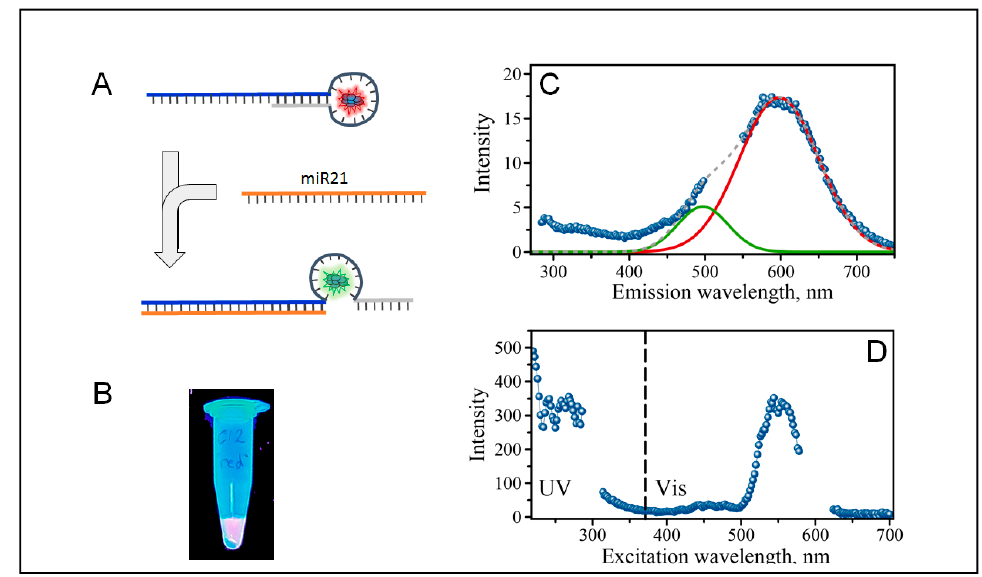
Figure 1. ( A ) Schematic representation of the template design and detection strategy, ( B ) a photograph of fluorescent glowing of silver nanoclusters (AgNCs) templated on C 12 -loop-miR21-probe under the UV excitation on trans-illuminator. ( C ) Fluorescence spectrum of AgNCs/C 12 -loop-miR21-probe recorded with 260 nm excitation wavelength, ( D ) Excitation spectrum of the AgNCs/C 12 -loop-miR21-probe for the emission at λ R = 600 nm. Gaps in the spectra are due to removal of the second order scattering. Green and red solid lines are plotted as “guide for the eye” in the positions of major “green” and “red” emission peaks.